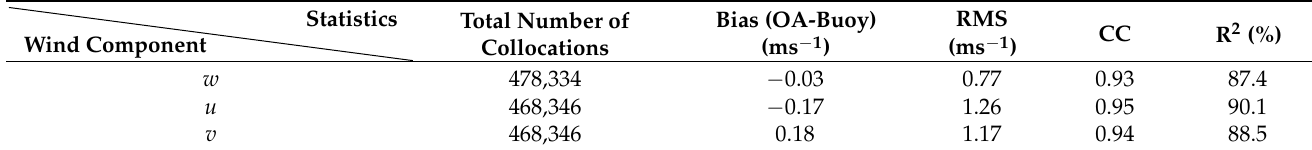
Table 2. Statistics of buoy evaluation of OAFlux-HR w , u , and